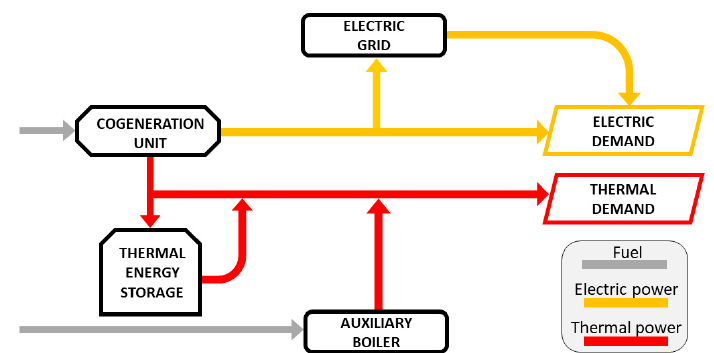
Figure 1. Schematic representation of the combined heat and power system.